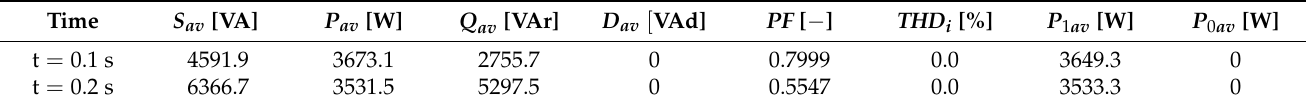
Table 15. Simulation results before and after the change (at steady states).